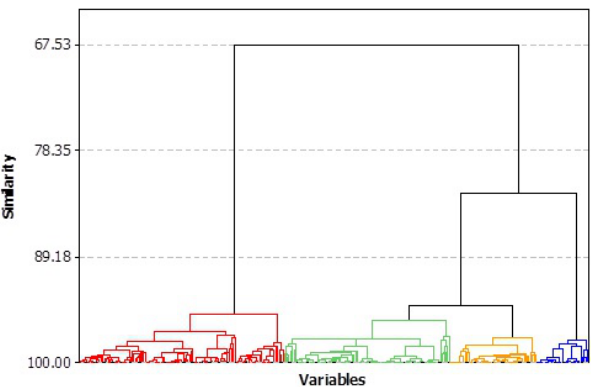
Figure 1. Dendrogram obtained from Ward’s agglomerative method; is pointed out the presence of 4 clusters with a similarity level greater than 95%.